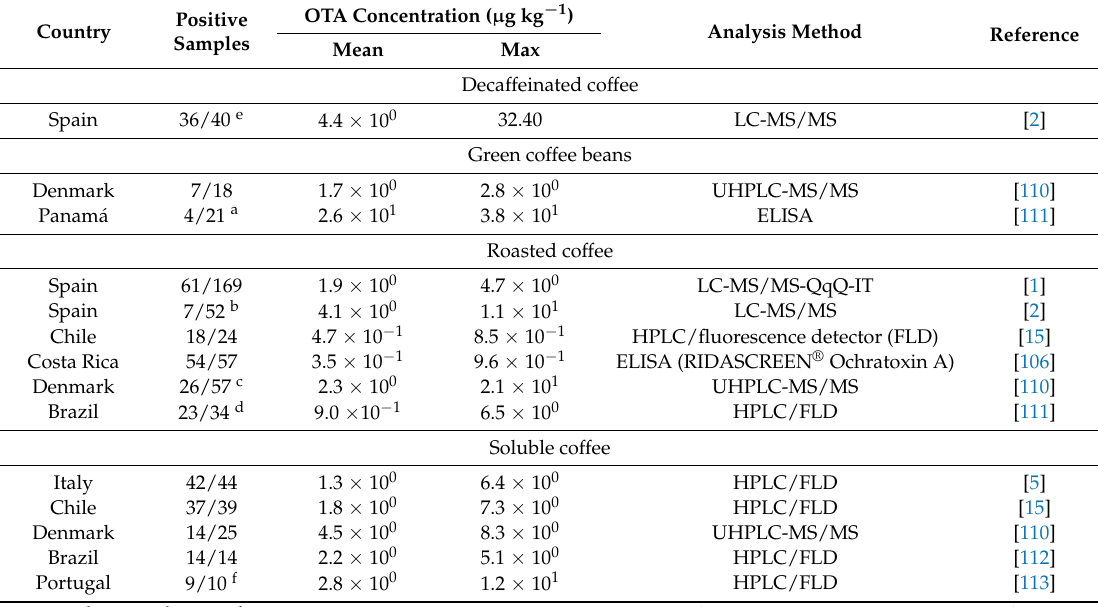
Table 3. The occurrence of OTA in green, roasted and soluble (instant) coffee